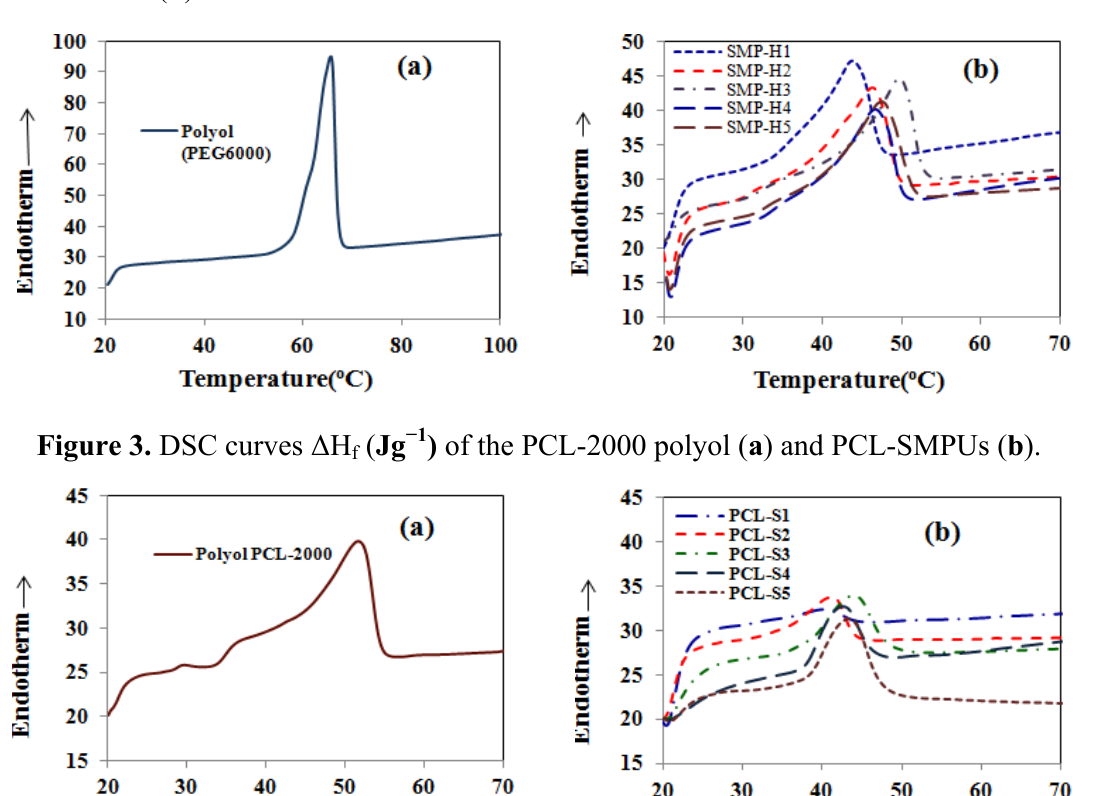
Figure 2. Differential scanning calorimetry (DSC) results of the PEG-6000 polyol ( a ) and PEG-SMPUs ( b ).